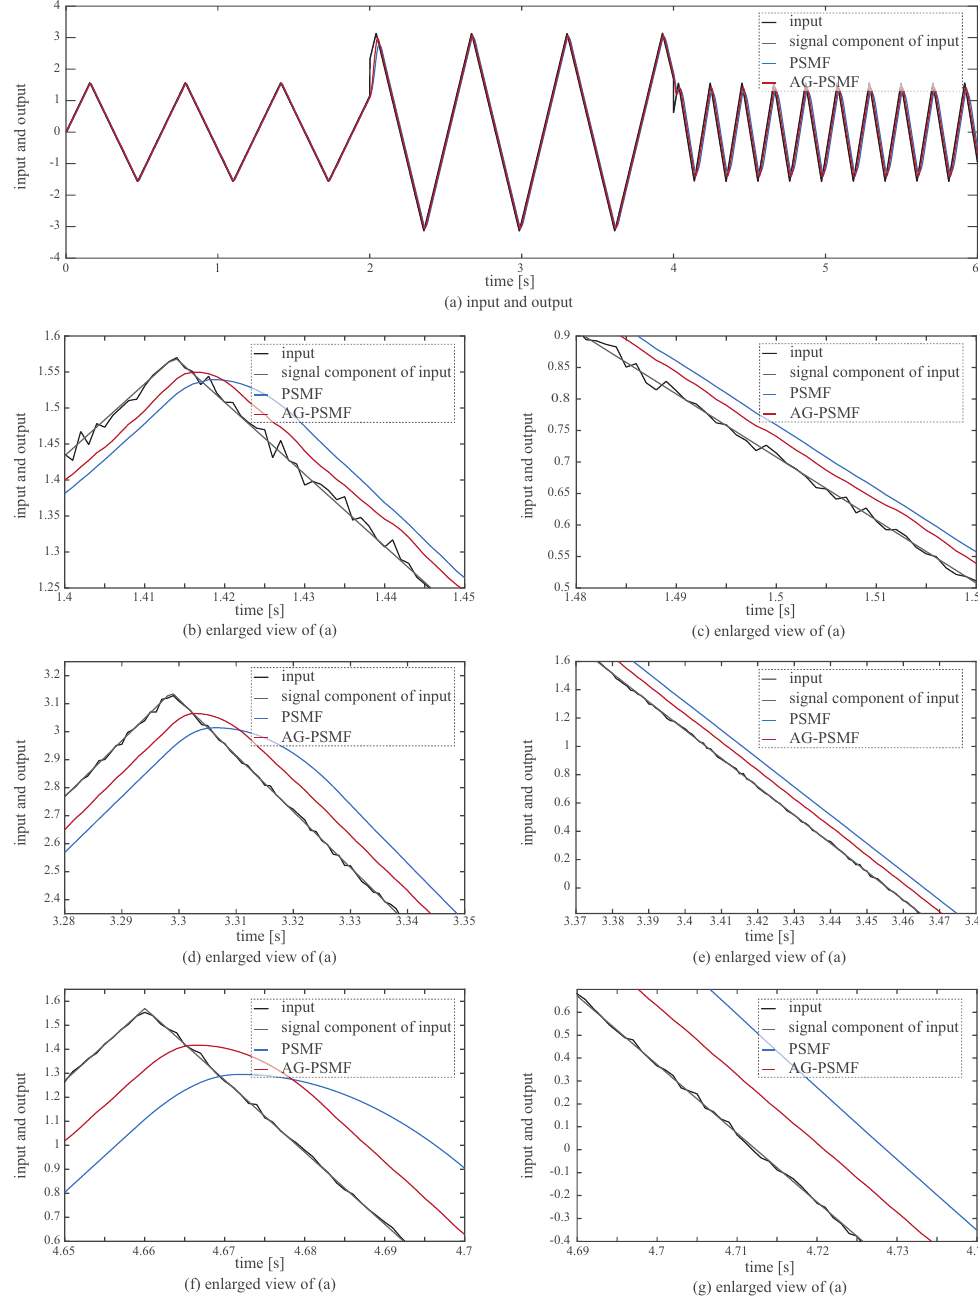
Figure 10. ( a – g ) Comparison between the outputs of AG-PSMF and PSMF for a triangular input that is corrupted by white Gaussian noise. (AG-PSMF: F = 1000, H = 3, N max = 5, N c = 4, R = 0.00075; PSMF: F = 1000, H = 3; T = 0.001